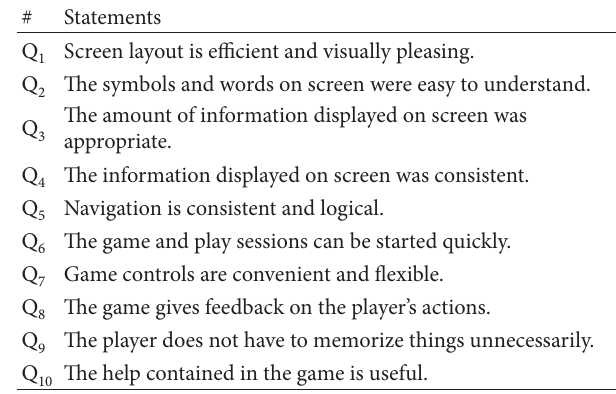
Table 4: Heuristics for evaluating game usability.